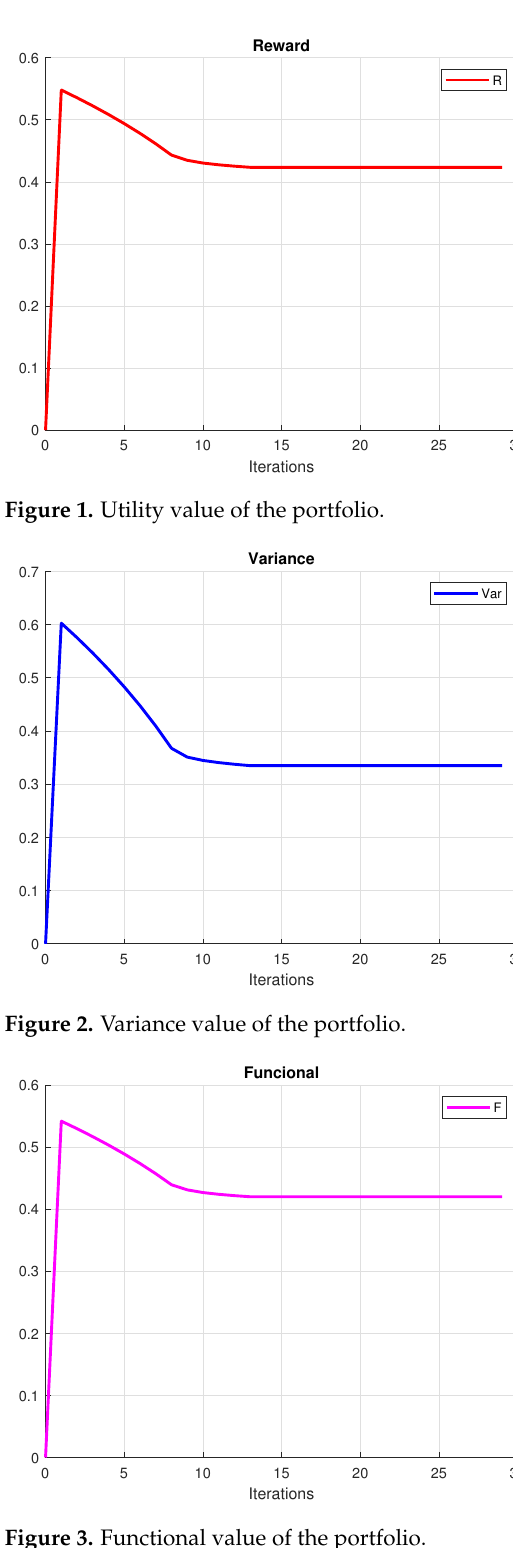
Figure 3. Functional value of the